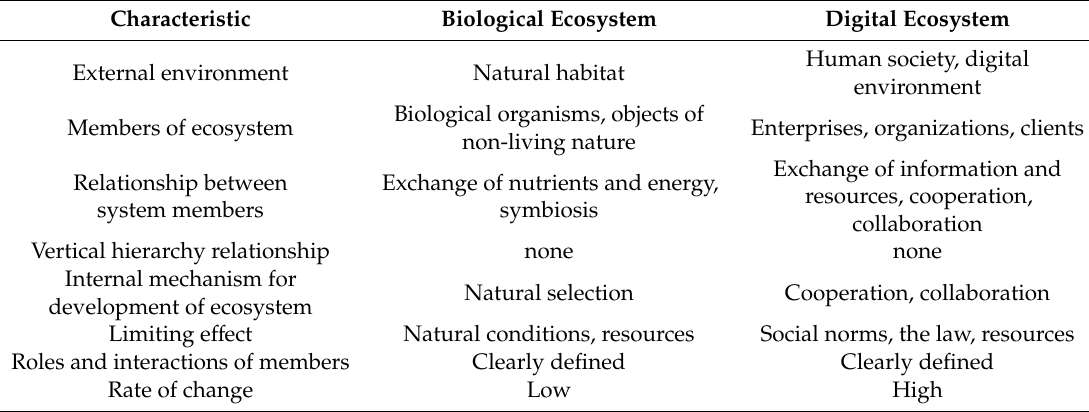
Table 1. Comparison of characteristics of biological and digital ecosystems